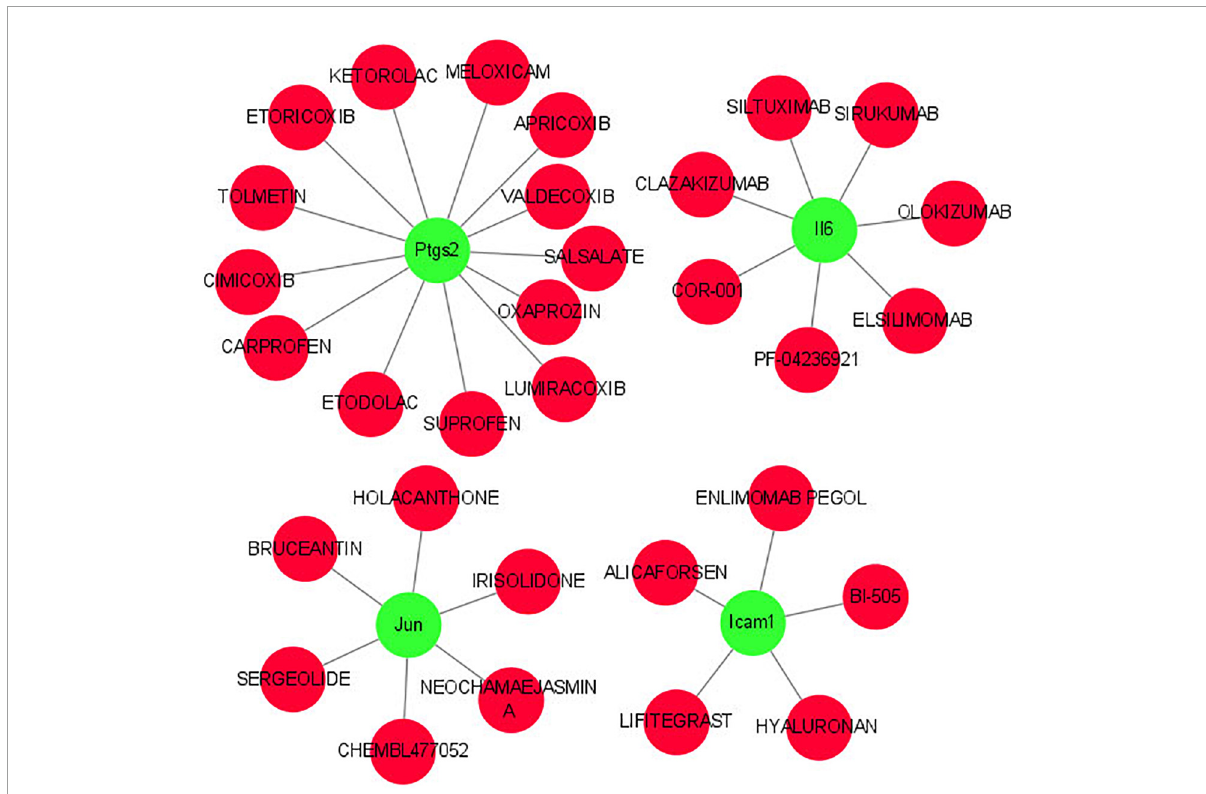
FIGURE8 Interaction network between core IRGs and potential drugs. Green nodes represent the hub IRGs (Ptgs2, Jun, Icam1, Il6); red nodes represent the potential drugs for TLE.